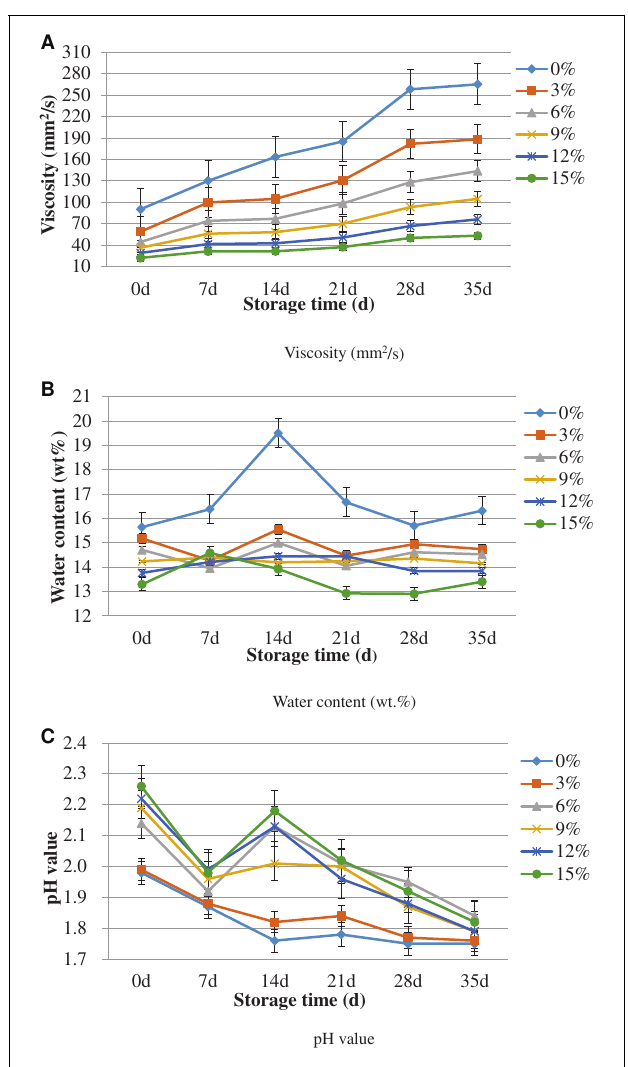
FIGURE 1 |The change of (A) viscosity (40°C), (B) water content, and (C) pH value of bio-oil during storage for 35days .